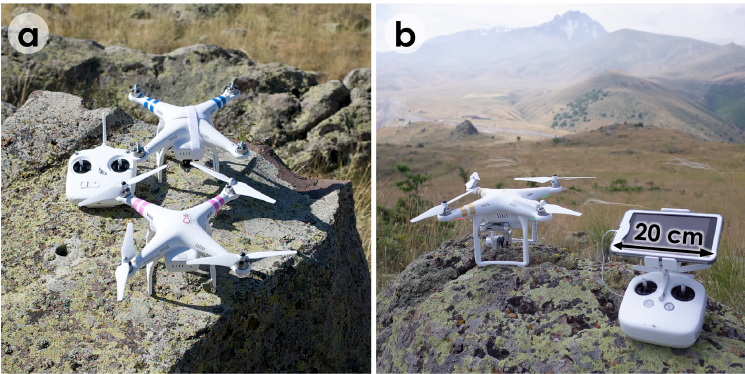
Figure 3. RPAS used in this study. (a) DJI Phantom 2. External digital cameras of Nikon Coolpix A and Ricoh GR are attached. (b) DJI Phantom 3 Professional with a built-in digital